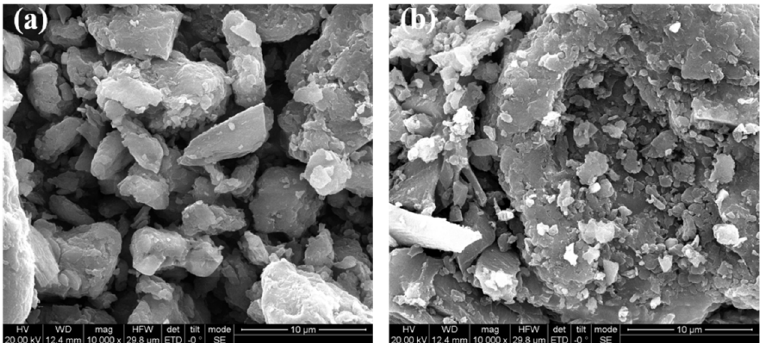
Figure 1. SEM images of SPFC500 ( a ) and SPFC800 ( b ).